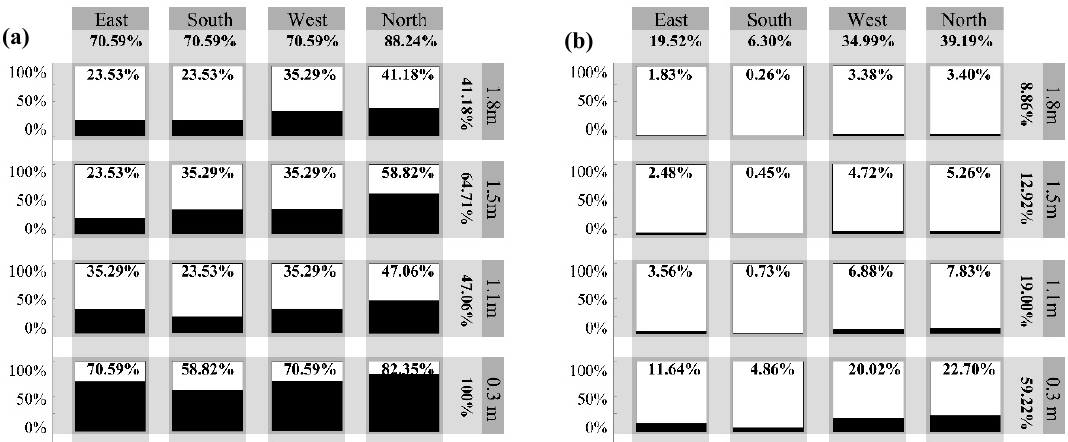
Figure 3. Proportions of the total species richness ( a ) and coverage ( b ) of epiphytic bryophytes on Schima superba tree trunks. The vertical bars represent different directions and the horizontal bars represent different trunk heights. Each small square represents the subplots that were investigated and the black portions represent the total species richness and coverage of bryophytes that have already occupied the subplot.